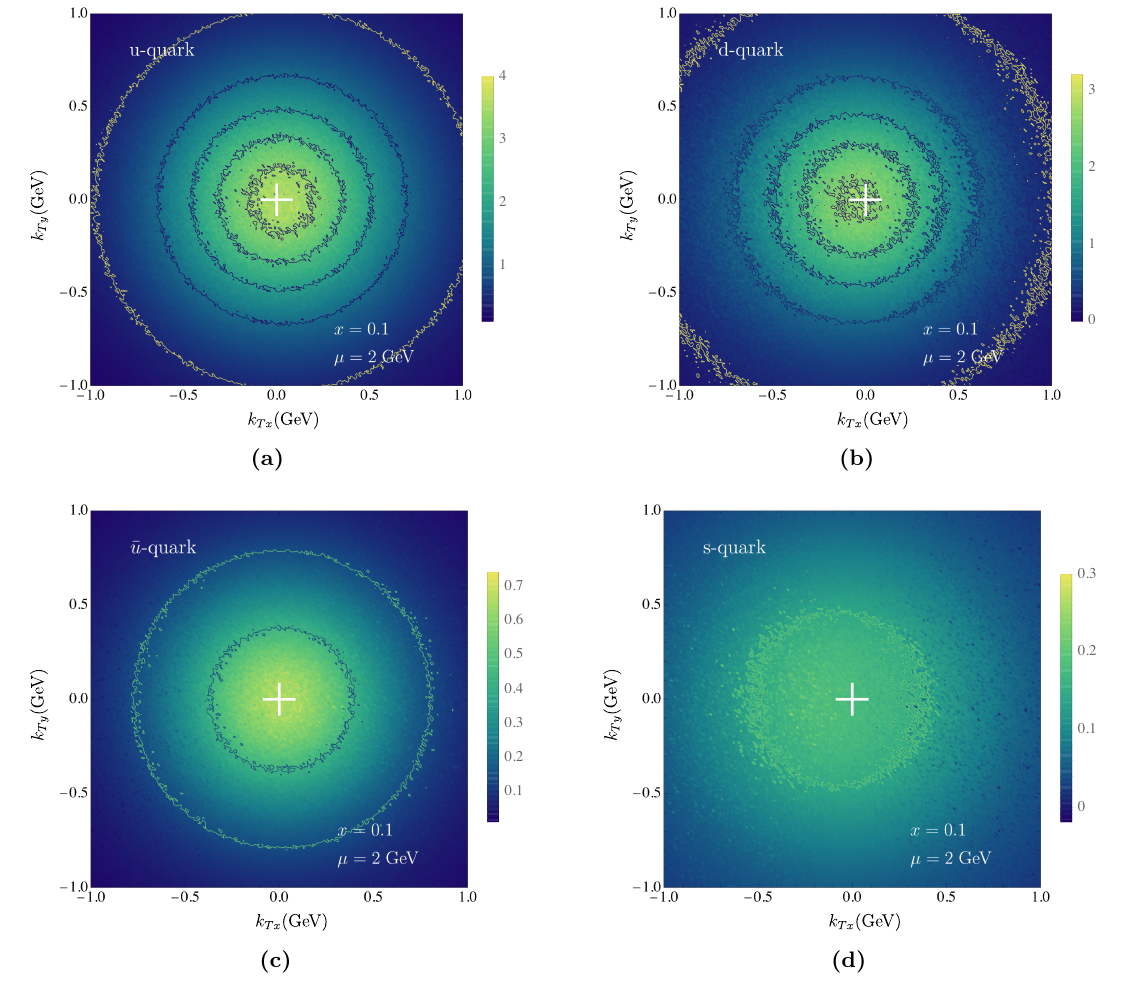
Figure 18. Tomographic scan of the nucleon via the momentum space quark density function ( x, k ) defined in eq. (4.7) at x = 0 . 1 and µ = 2 GeV. Panel (a) is for u quarks, panel ρ T , S T , µ 1; q ← h ↑ (b) is for d quark, panel (c) is for ¯ u quark, and panel (d) is for s quark. The variation of color in the plot is due to variation of replicas and illustrates the uncertainty of the extraction. The nucleon polarization vector is along ˆ y -direction. White cross indicates the position of the origin (0 , 0) in order to highlight the shift of the distributions along ˆ x -direction due to the Sivers